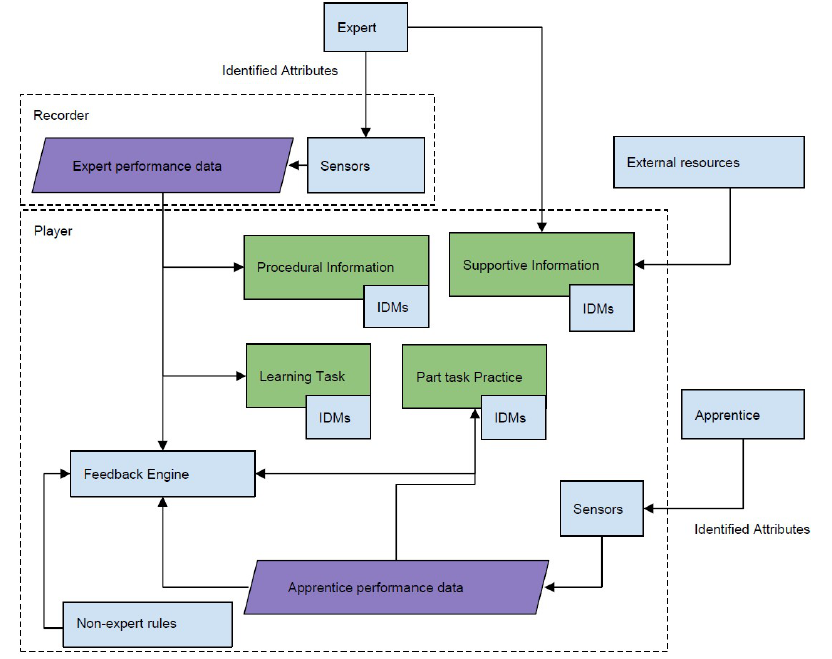
Figure 2. System Model for supporting the